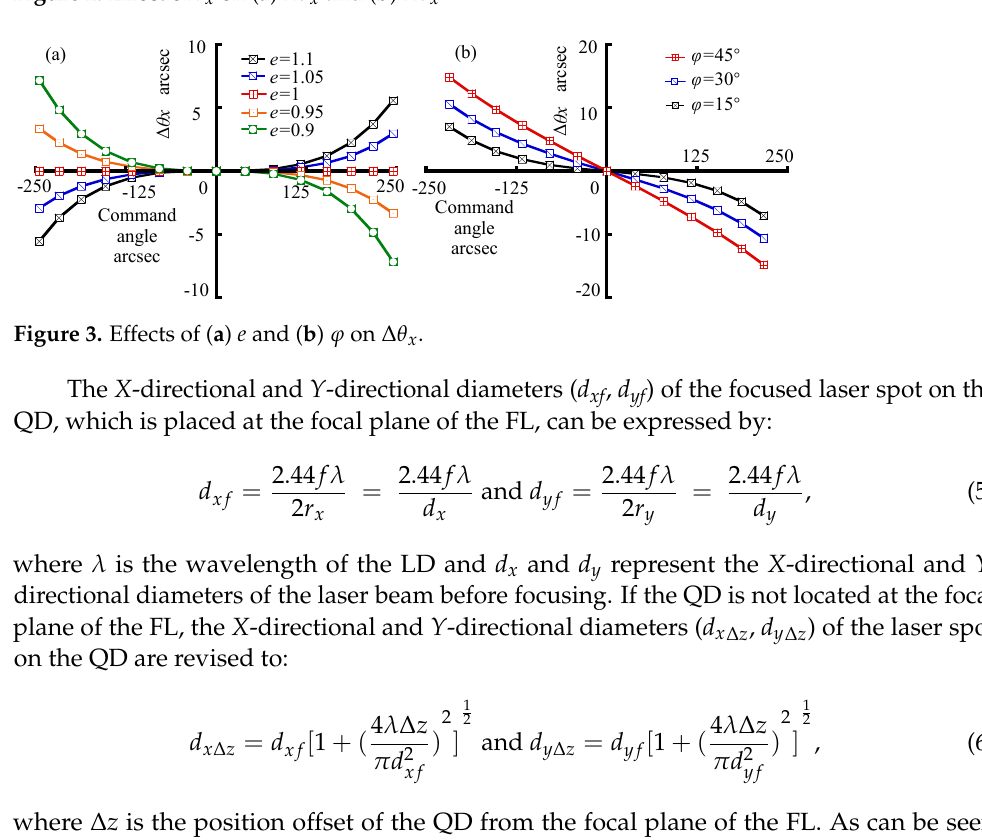
Figure 2. Effect of r x on ( a ) ∆ δ x and ( b ) ∆ θ x .